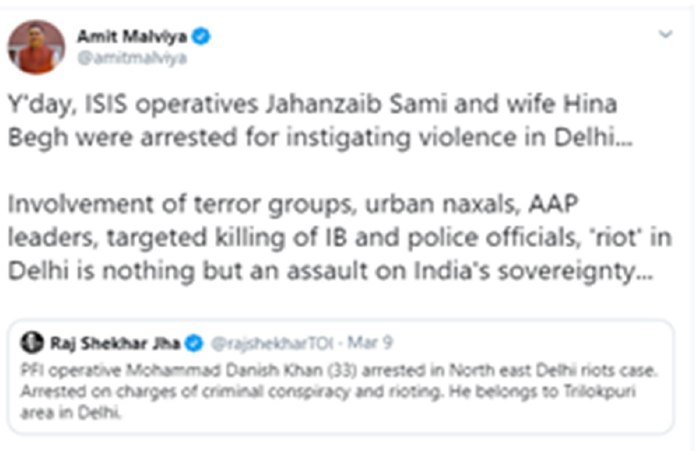
Figure 8. BJP IT cell head Amit Malviya’s tweet falsely linking the arrest of IS inspired couple with Delhi riots.